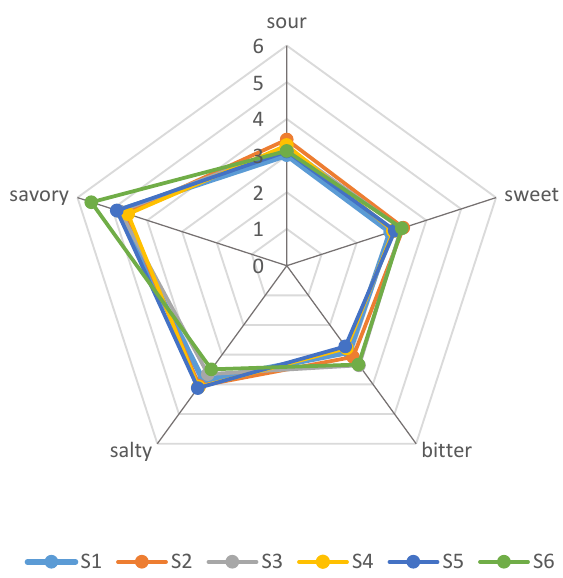
Figure 4. Graph of the sensory analysis of the Pixian broad-bean paste samples.